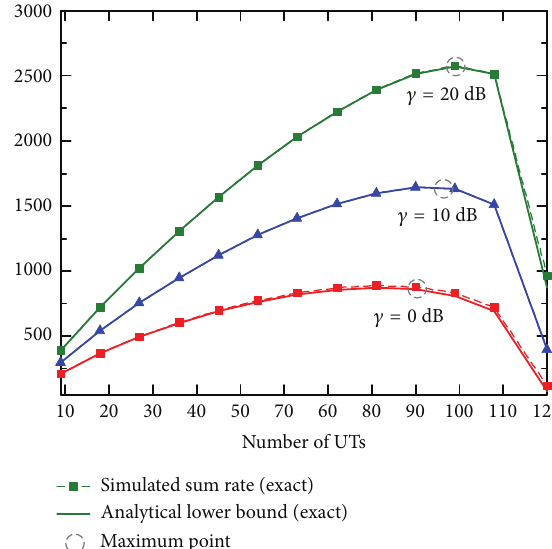
Figure 7: Analytical sum rate and lower bound versus the number of UTs ( 𝛾 = 0, 10,20 dB, 𝑁 𝑡 = 1 , 𝑁 𝑟 = 120